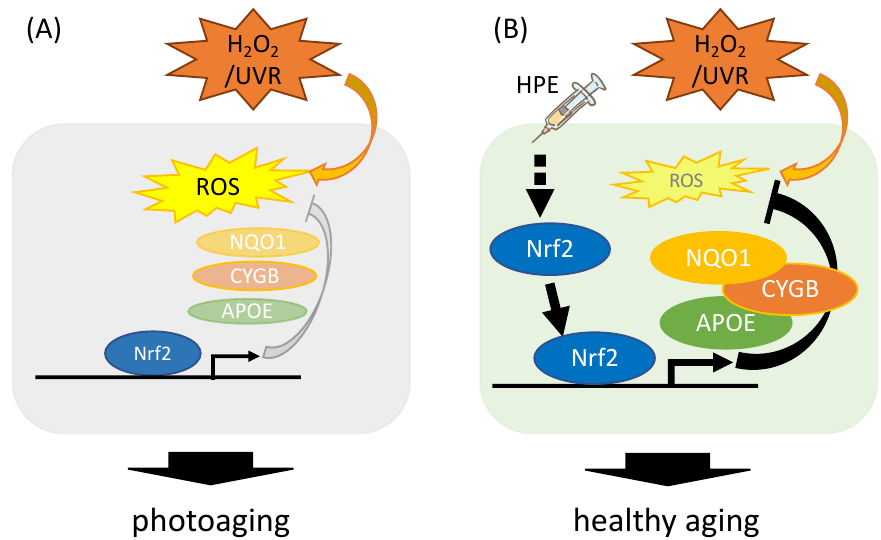
Figure 5. Schematic representation of the HPE-dependent regulation on antioxidant machinery. ( A ) Under normal conditions, H 2 O 2 /UVR produces ROS, which promotes cellular senescence and photoaging. ( B ) Under HPE-treated conditions, HPE increases the active form of NRF2, via unknown mechanisms, and decreases cell susceptibility to oxidative stress, thereby delaying cellular senescence and possibly improving skin aging.